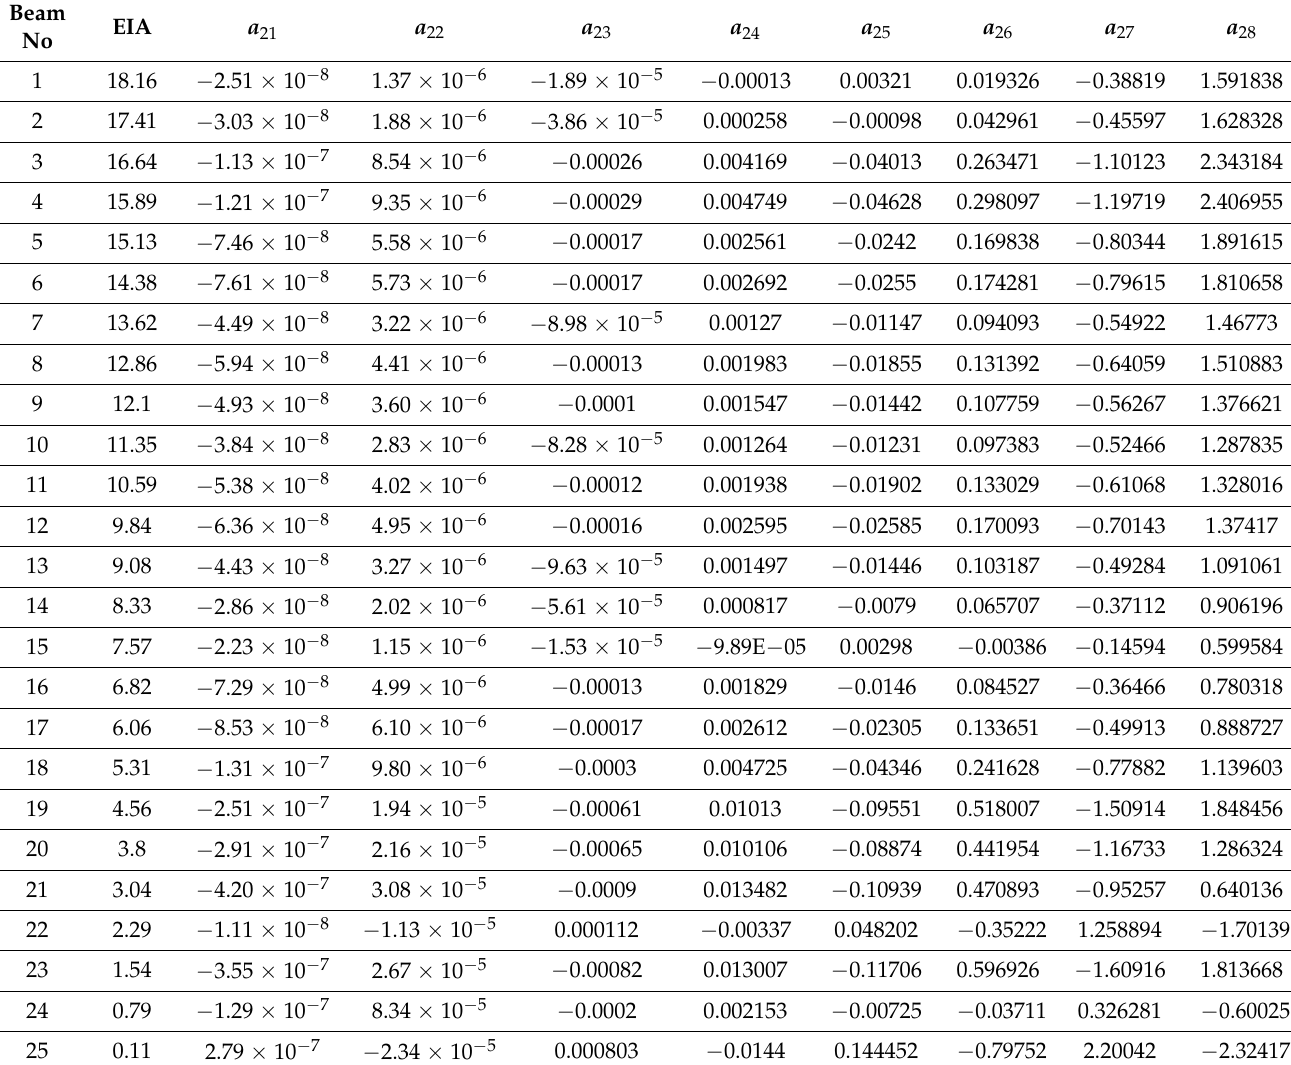
Table A3. Polynomial coefficients for Ku-band A 2 model in dB (Equation